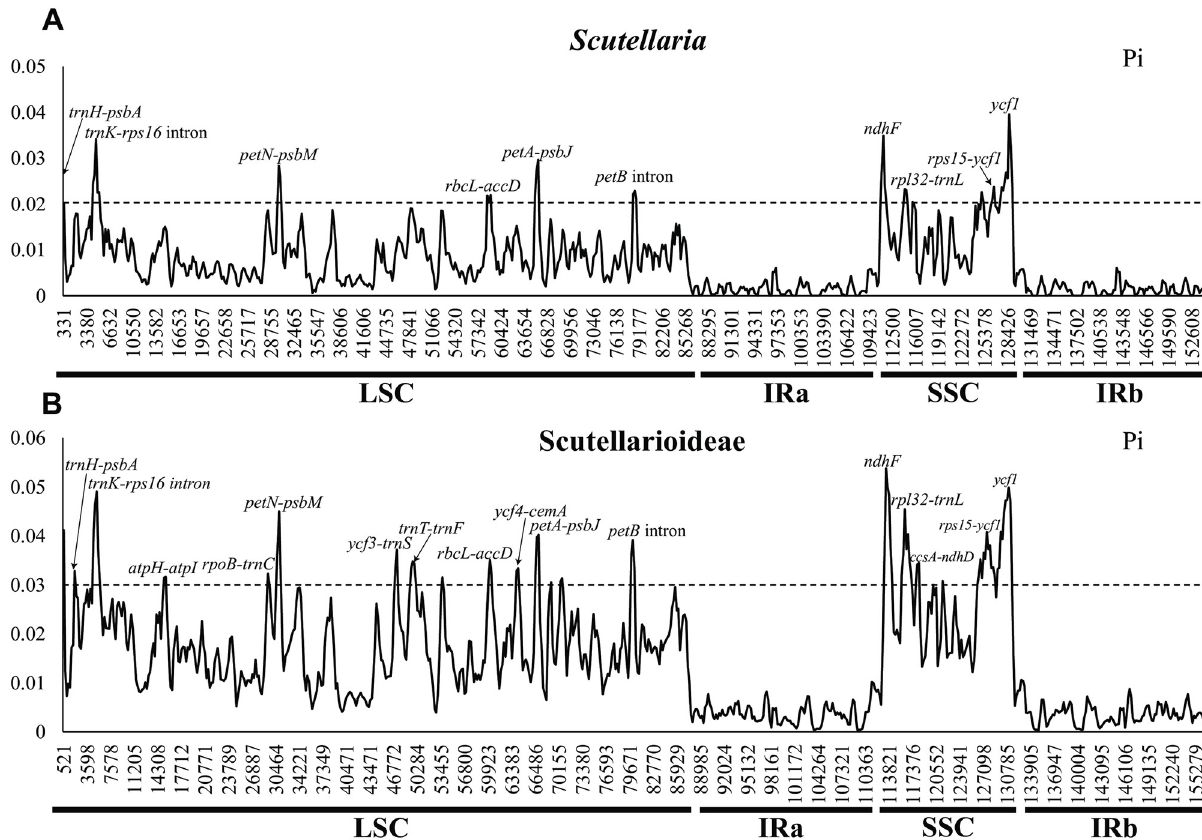
Fig 7. Sliding window analysis of the whole chloroplast genomes. (A) the 11 species of Scutellaria ; (B) the 15 samples of Scutellarioideae.